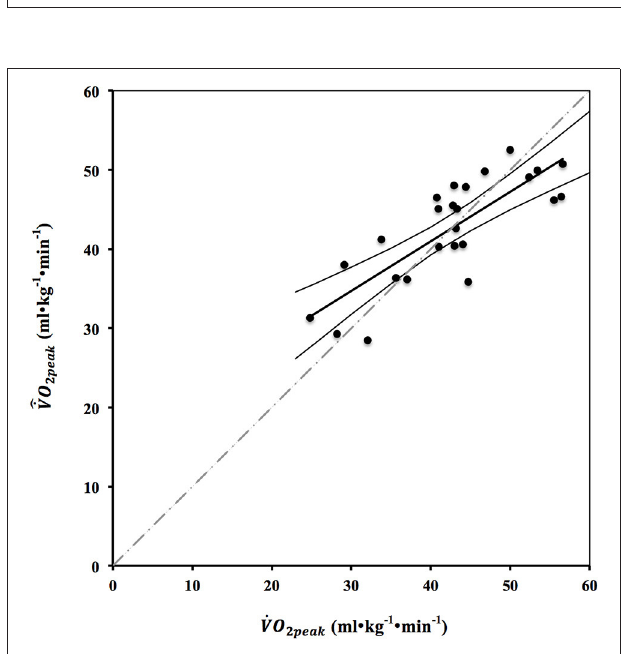
b ˙ VO 2peak FIGURE 3 | Relation between measured ˙ VO 2peak and predicted b ˙ VO 2peak = 7.46 · v test + 261.4 · v off − estimated from multiple linear regression 0.19 · 1 HR. Trend line (thick black line) expresses the linear regression between b ˙ VO 2peak = 0.62 ˙ VO 2peak + 15.9; r = 0.80). The thin black lines the variables ( are the confidence interval (95%) of the trend line, while the dashed gray line is the identity line.